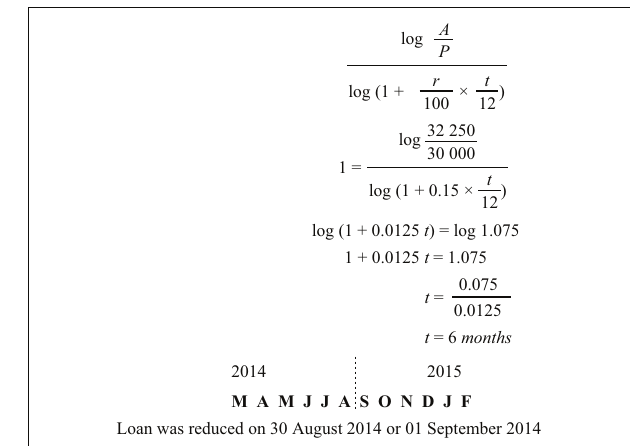
FIGURE 23: Date on which the loan was